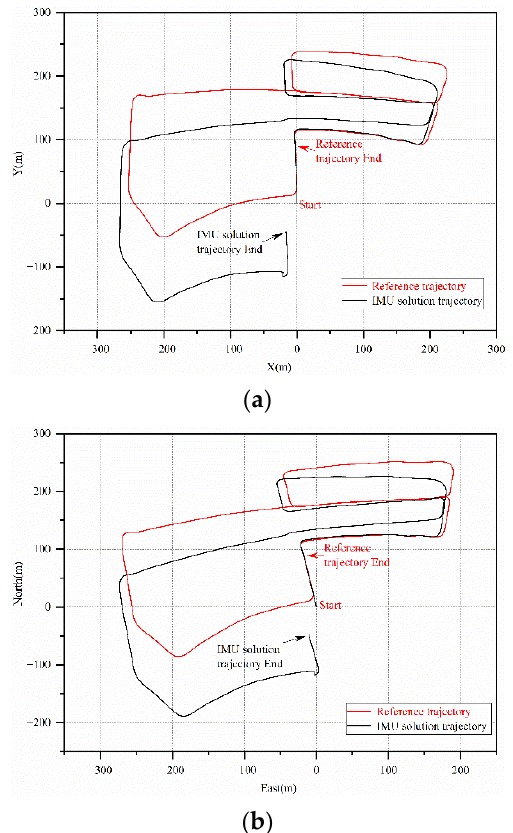
Figure 4. Reference trajectory and INS solution trajectory: ( a ) trajectory in b0 system; ( b ) trajectory in the n system.